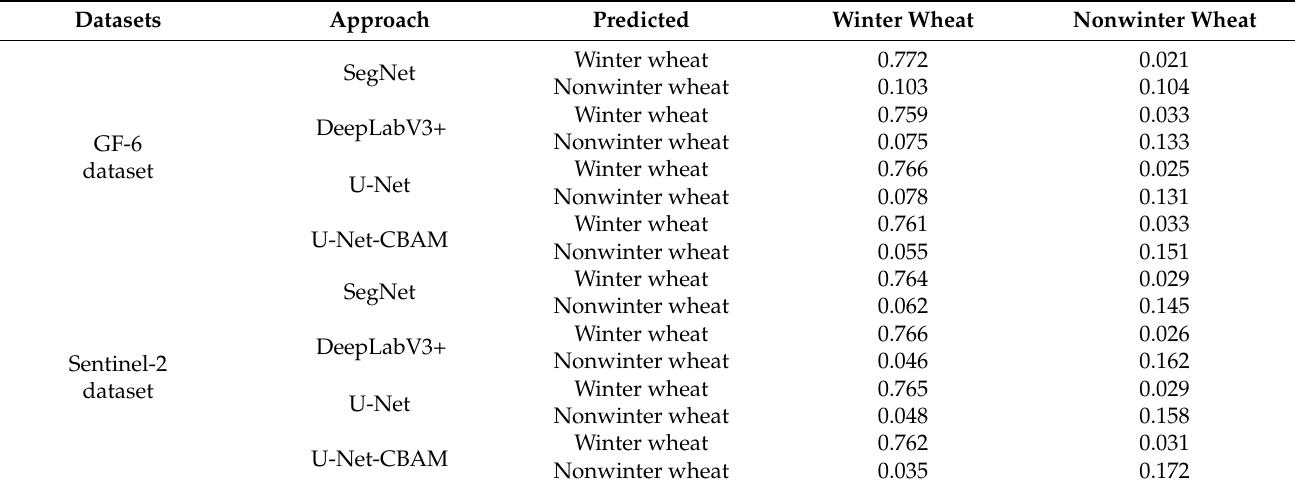
Table 4. Confusion matrix of winter wheat classification.